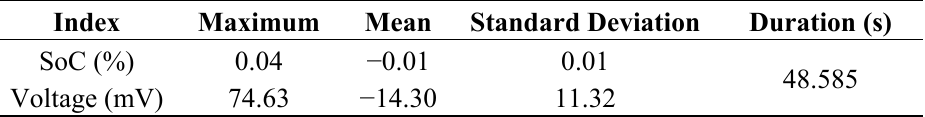
Table 4. Statistical results of the SoC estimation